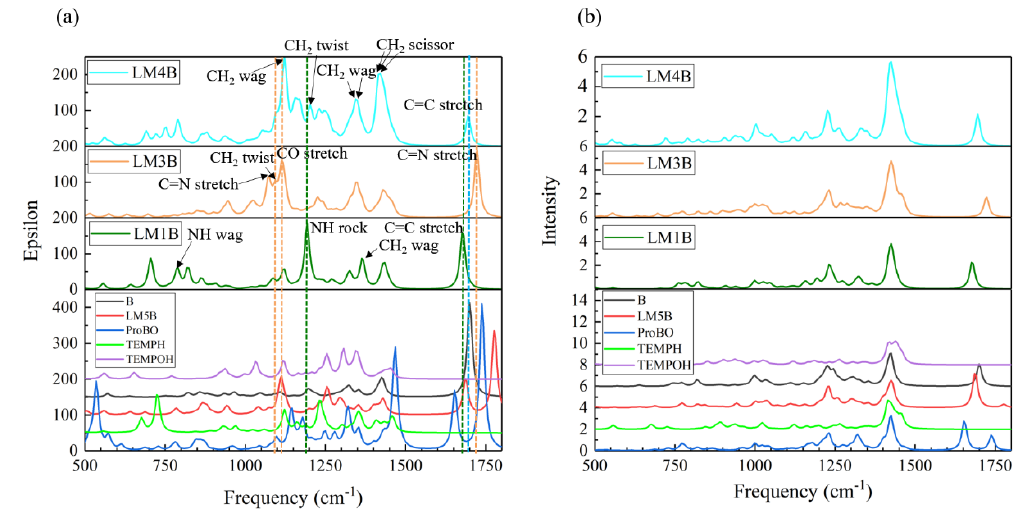
Figure 7. Calculated IR ( a ) and Raman ( b ) spectrum for each species in imine reaction pathway. The half-width at half height of IR and Raman peaks is 10 cm − 1 .